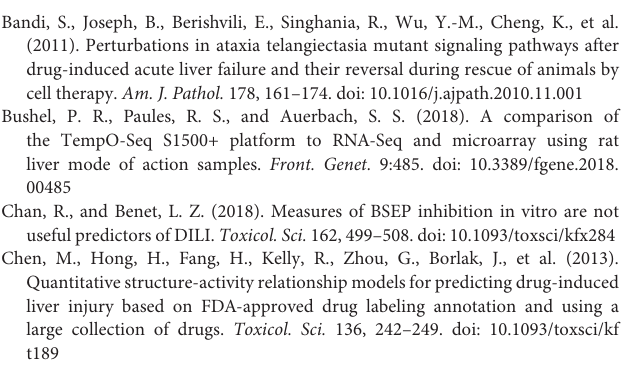
Supplementary Figure 1 | The distrubition of Euclidean distances among the 23,791 transcriptomic profiles of LINCS L1000 data. Supplementary Figure 2 | The model structure of the developed DNN model. Supplementary Figure 3 | Enriched canonical pathways by using